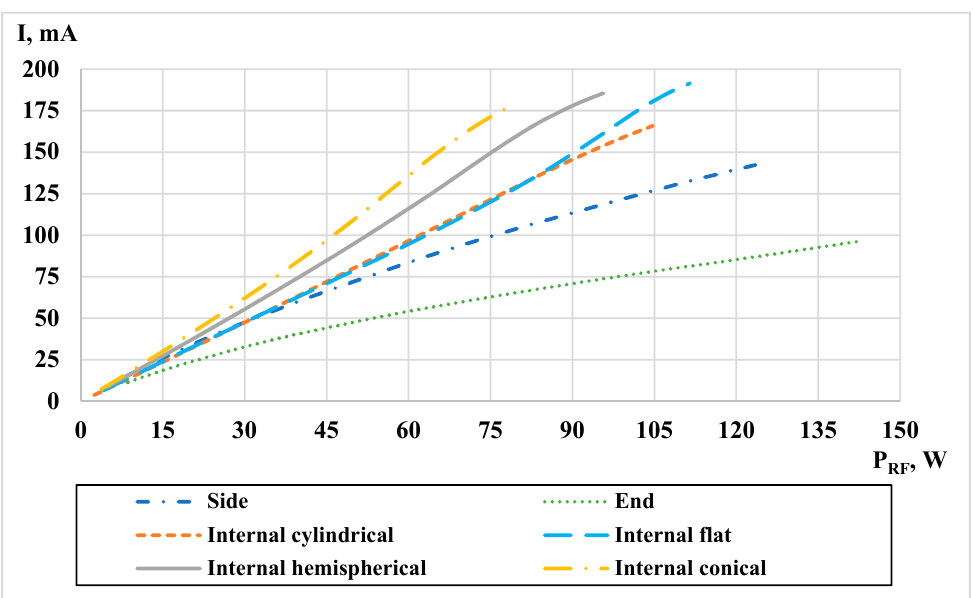
Figure 3. Dependences of the extracted ion current on the RF power input to the plasma at the xenon flow rate of 0.5 mg/s.